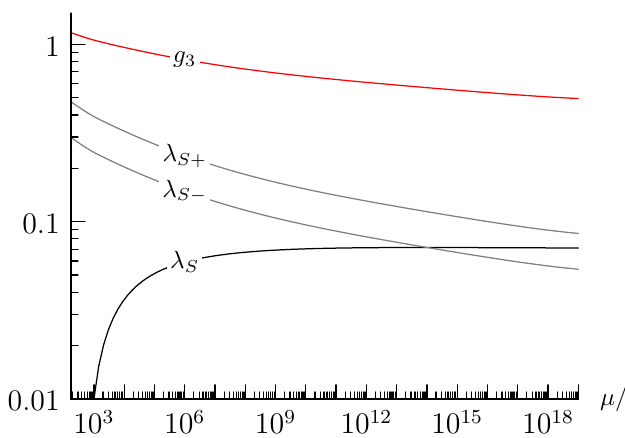
3 in the case where we set (cid:21) S of = 0 at (cid:21) S . Between (cid:21) S and (cid:21) S + the (cid:12) -function is negative and S (cid:6) (cid:0)